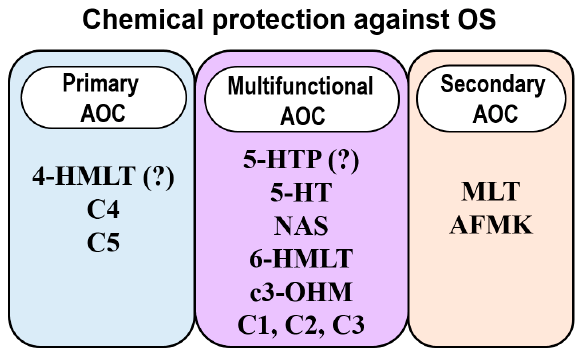
Figure 5. MLT, and related compounds, grouped according to their main AOC. A question mark next to the acronym of a compound means that further investigations are needed to confirm the proposed classification, thus its position can eventually change. AFMK = N 1 -acetyl- N 2 -formyl-5-methoxykynuramine, c3-OHM = cyclic 3-hydroxymelatonin.